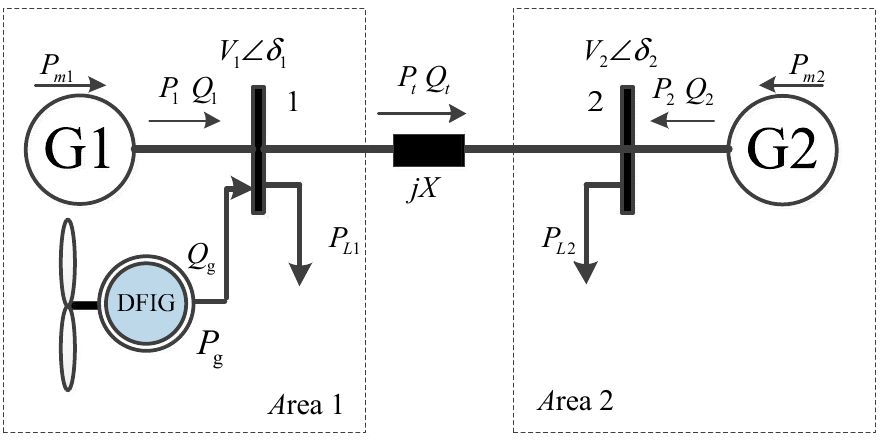
Figure 2. Simple power system model.